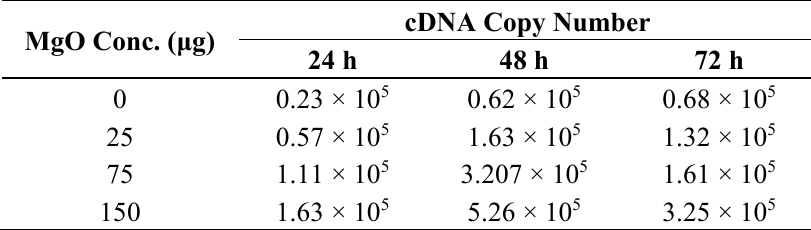
Table 2. The expressed catalase gene number with variation in MgO concentration and incubation time.